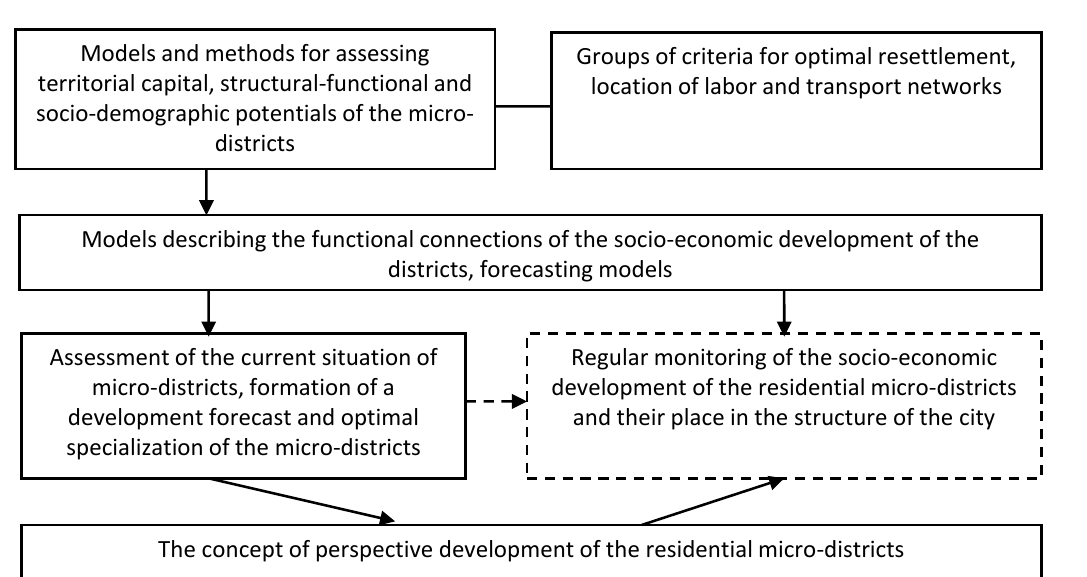
Figure 1. The scheme of the methods for shaping the concept of perspective development of